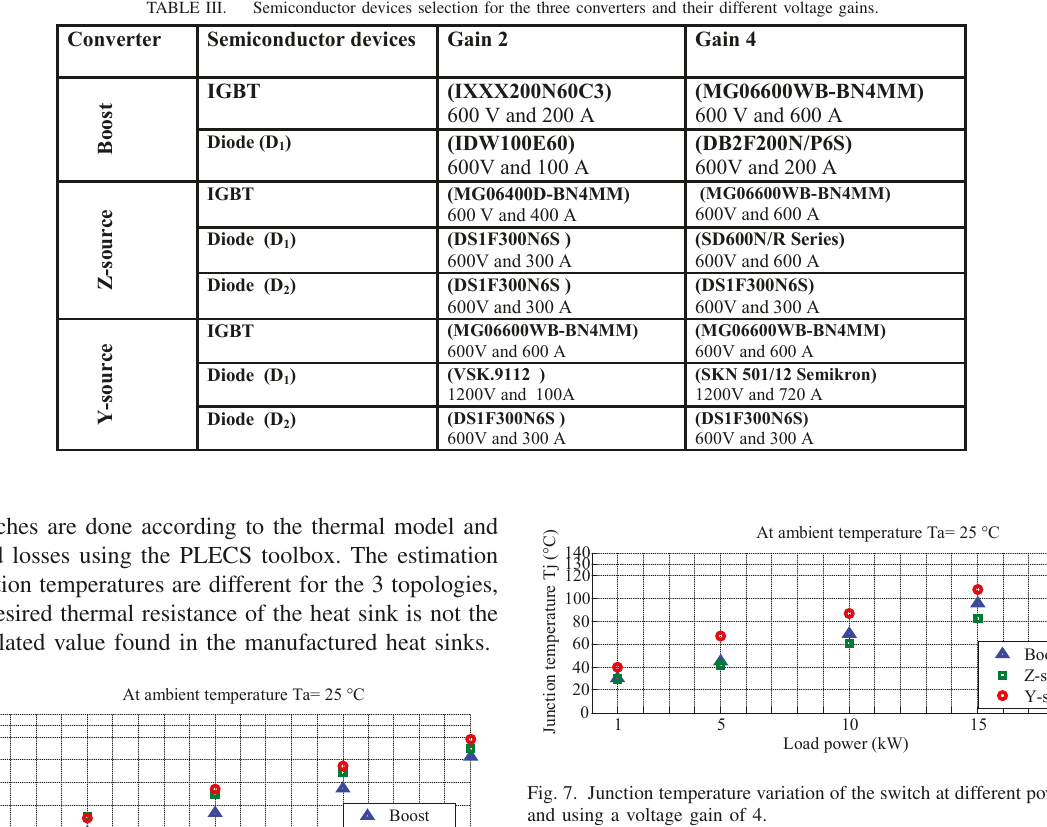
topologies are shown in Fig. 6 for voltage gain of 2. Fig. 7 power for voltage gain of